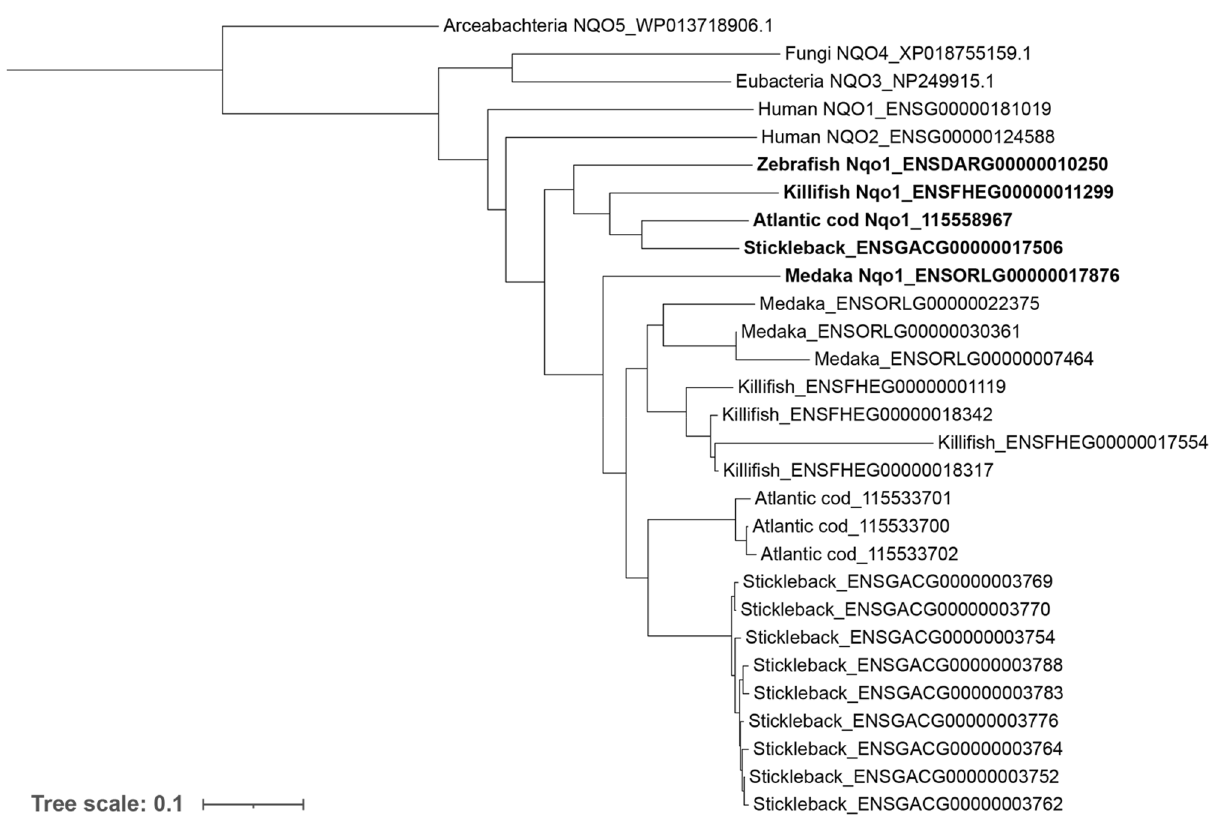
Figure 2. Phylogenetic tree of NAD(P)H:quinone oxidoreductases (NQO), also known as DT-diaphorase (DTD). Multiple sequence alignment and phylogenetic tree was built using Clustal Omega 50 with standard settings. The tree was drawn using iTol 51 , and rooted with the archaebacterial